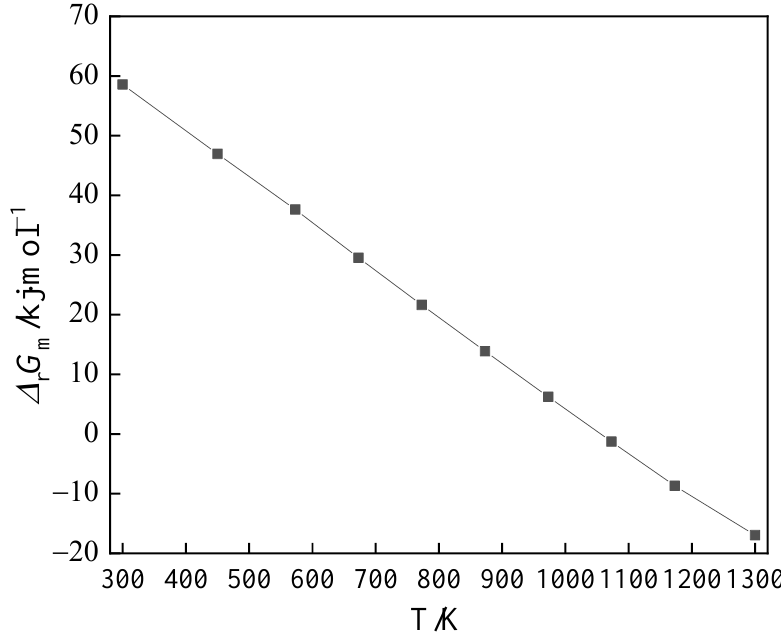
Figure 4. Gibbs free energy change of standard molar reaction of stage one ( Δ r G m).